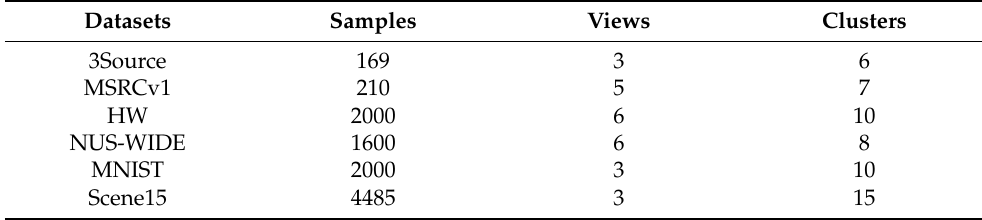
Table 1. Statistics of the six datasets.